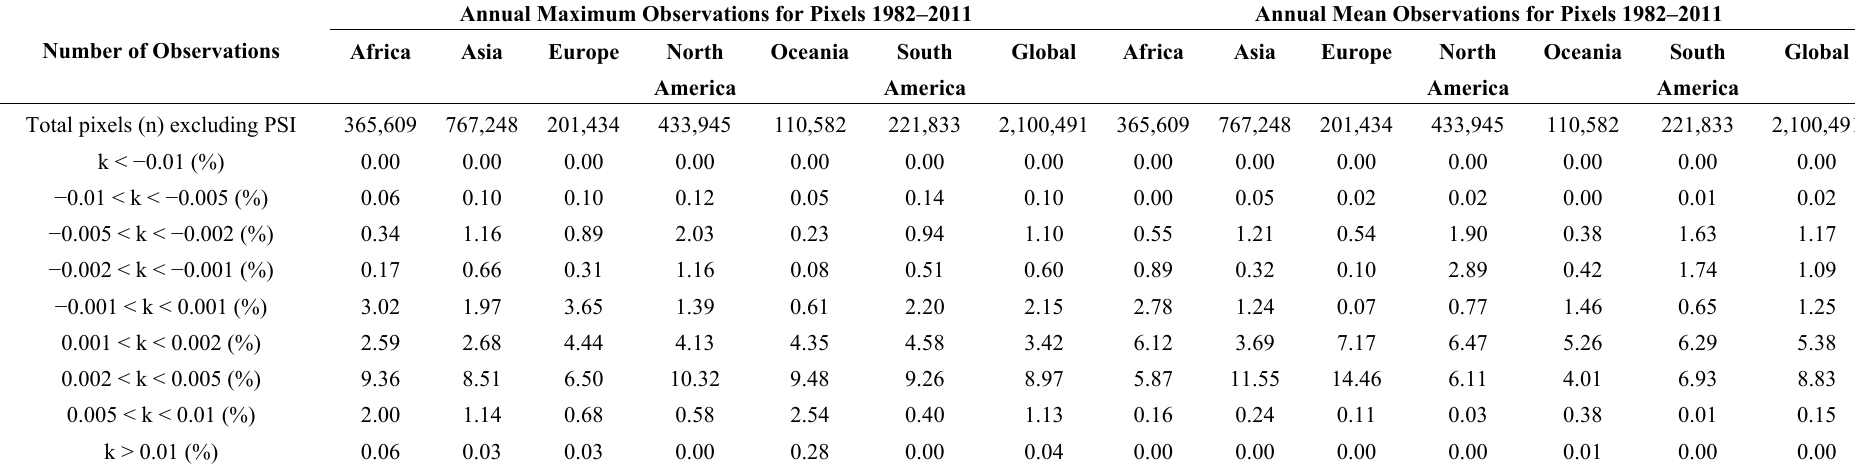
Table 4. Trend statistics for the GIMMS FVC analysis 1982–2011 ( p = 0.05) for all the continents. Permanent land snow and ice with limited or no vegetation growth are masked (PSI, permanent snow, ice and barren land).